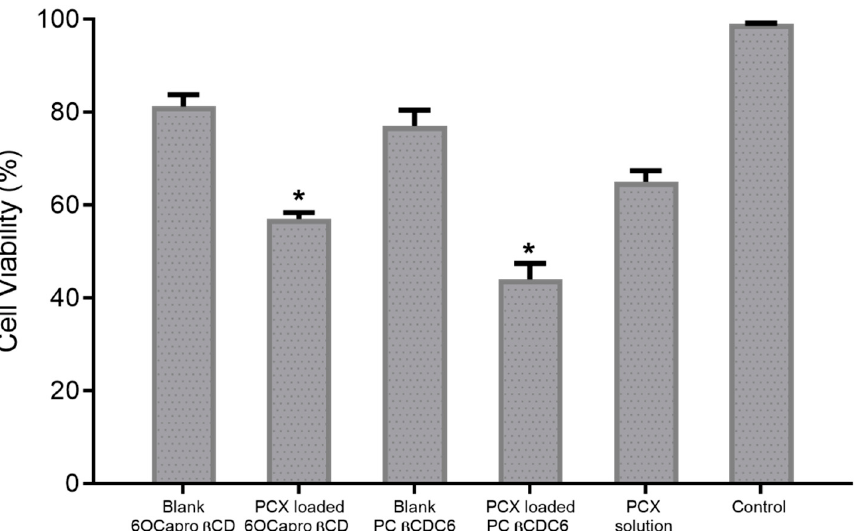
Figure 6. Anticancer effect of paclitaxel (PCX) solution and PCX-loaded amphiphilic cyclodextrin (CD) nanoparticles against 3D 4T1 spheroids for 48 h. Cells incubated with the complete DMEM were considered as control and 100% viable. Cell viability was determined with WST-1 colorimetric assay (n = 4; mean ± SD). * p < 0.05 compared with PCX solution.